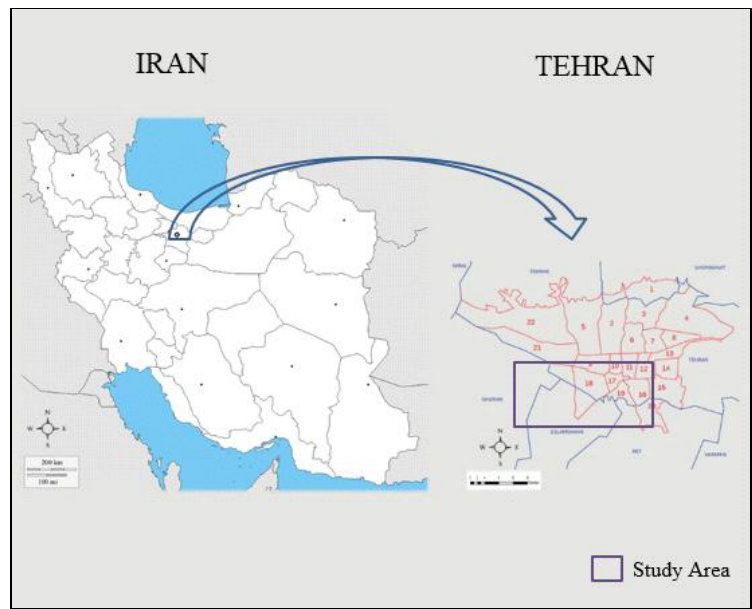
Fig. 1: Scope of Iran and Tehran